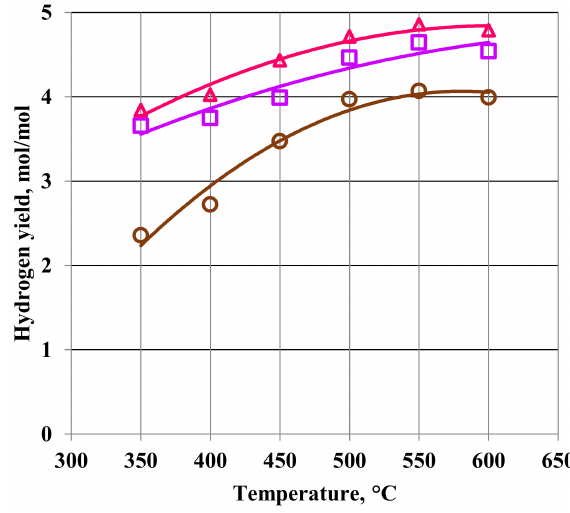
Figure 8. The influence of temperature and feed flow composition on the hydrogen yield. Feed flow rate = 0.4 mol/h. Water to ethanol molar ratio in the feed: ∆ = 5, (cid:101) = 4, and o = 3.